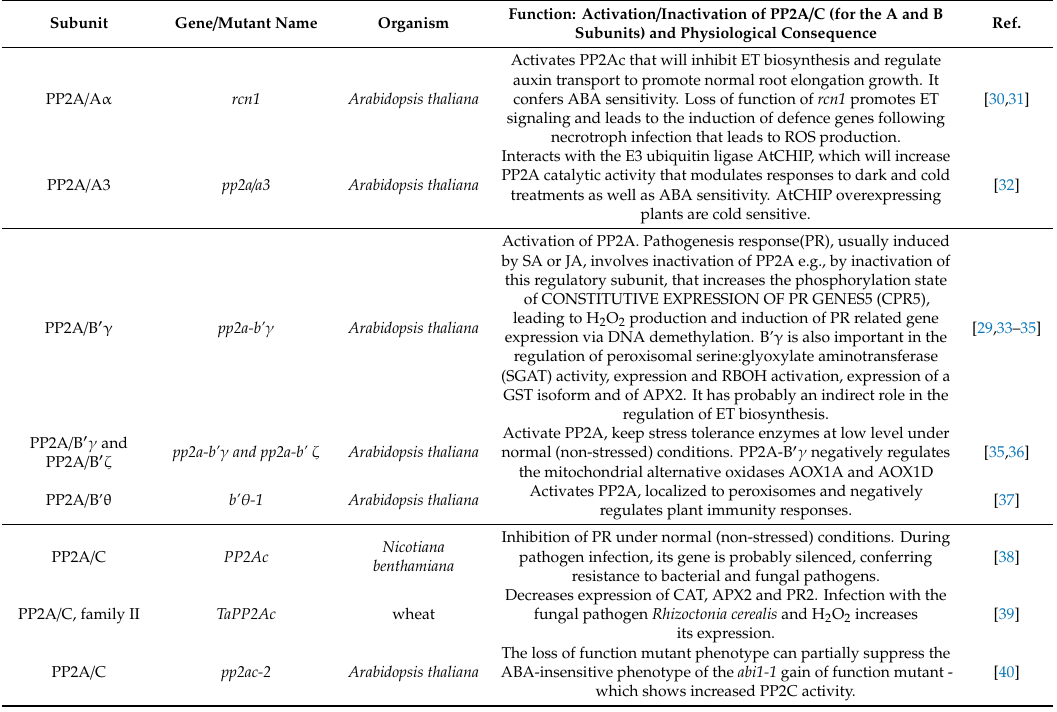
Table 1. Some important examples of A (sca ff olding), B (regulatory) and C (catalytic) subunits of plant PP2A complexes in relation to oxidative stress responses. / Inactivation of PP2A / C (for the A and B Gene / Mutant Name Organism Function: Activation Subunits) and Physiological Consequence Ref. Activates PP2Ac that will inhibit ET biosynthesis and regulate auxin transport to promote normal root elongation growth. It Arabidopsis thaliana confers ABA sensitivity. Loss of function of rcn1 promotes ET signaling and leads to the induction of defence genes following necrotroph infection that leads to ROS